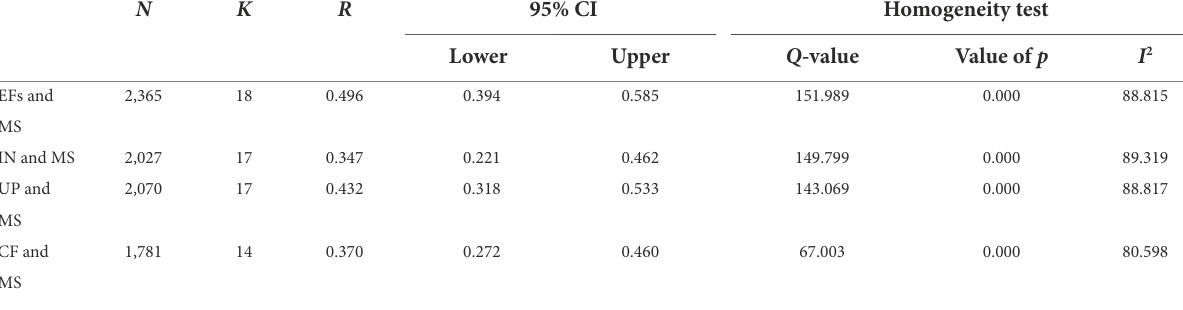
TABLE 2 Main effects results for executive functions and mathematical